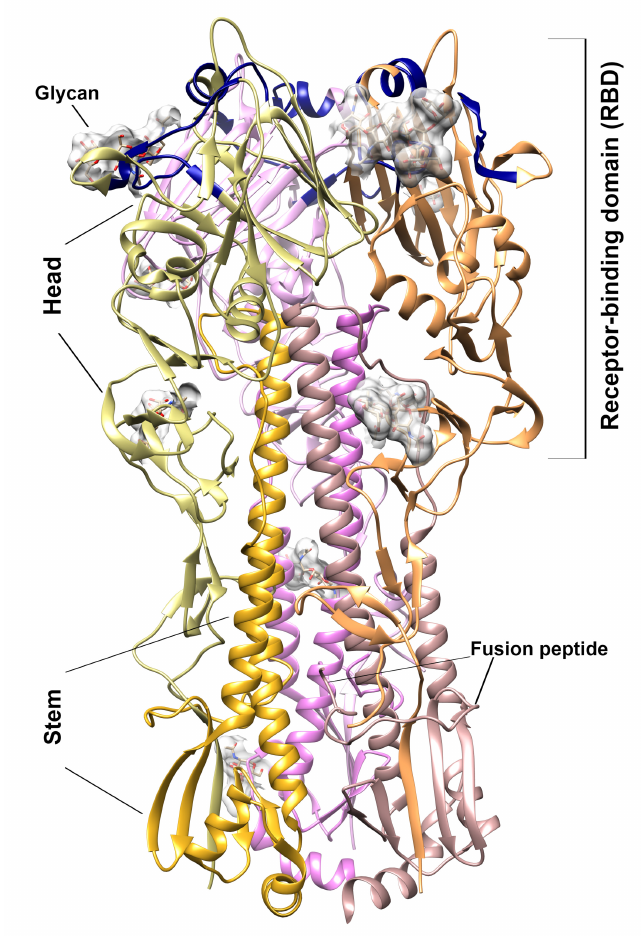
Figure 1. 3D structure of the hemagglutinin from H3N2 A/Hong Kong/1968 (pdb 5t6n). Ribbon presentation of the trimer structure. The HA 1 and HA 2 subunits are discriminated by different colors. The glycan moieties presented in the solved structure are shown by the gray surface. The receptor-binding site—130 loop (epitopes 130–140), 190- α -helix (epitopes 190–199), and 220-loop (epitopes 220–230)—is highlighted by dark